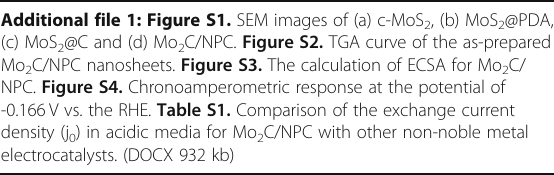
Additional file 1: Figure S1. SEM images of (a) c-MoS 2 , (b) MoS 2 @PDA, (c) MoS 2 @C and (d) Mo 2 C/NPC. Figure S2. TGA curve of the as-prepared Mo 2 C/NPC nanosheets. Figure S3. The calculation of ECSA for Mo 2 C/ NPC. Figure S4. Chronoamperometric response at the potential of -0.166V vs. the RHE. Table S1. Comparison of the exchange current density (j 0 ) in acidic media for Mo 2 C/NPC with other non-noble metal electrocatalysts. (DOCX 932